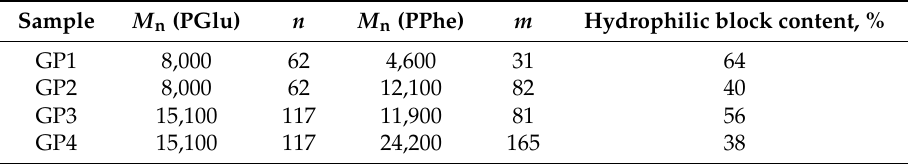
Table 2. Molecular mass characteristics of synthesized amphiphilic PGlu- b -PPhe copolymers.